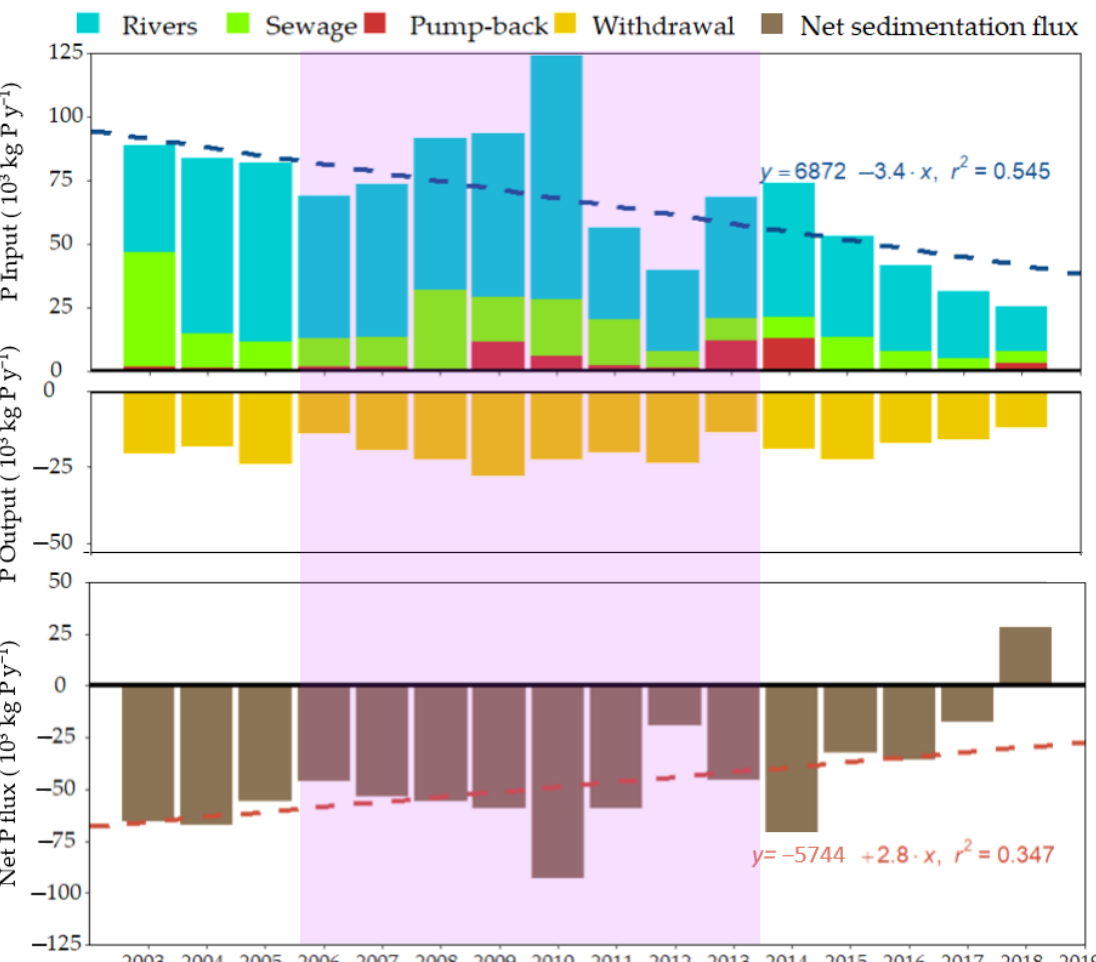
Figure 4. Annual P budgets for VB from 2002–2018. Top panel shows the inputs from rivers, sewages and pump-back from the other reservoirs of the Cutzamala System. Middle panel depicts the output through water withdrawal. Bottom panel shows the NIP ( P ) yielded by the P budget, which corresponds to the net P annual flux to the sediments or P net sedimentation. The dashed lines in the top and the bottom panels indicate the input and NIP ( P ) trend for the 2003–2018 period overall. The equation corresponds to a linear regression of this trend, together with its correlation